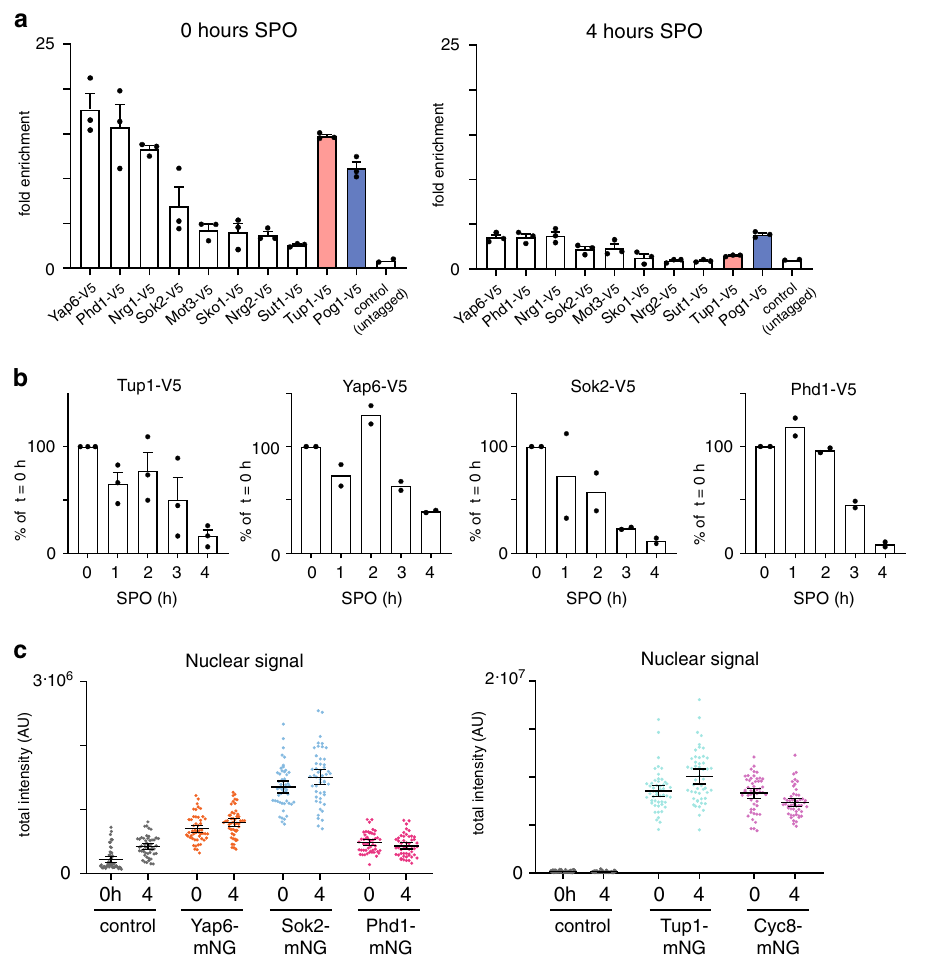
Fig. 6 Tup1 – Cyc8 and TFs dissociate without translocating to the cytoplasm. a Binding of TFs at the IME1 promoter prior to and during entry into meiosis. Diploid cells harbouring V5 tagged TFs ( YAP6- V5, FW3833; PHD1-V5 , FW4466; NRG1-V5 , FW4393; SOK2-V5 , FW5638; MOT3-V5 , FW4383; SKO1-V5 , FW4389; NRG2-V5 , FW4396; SUT1-V5 , FW6974; TUP1-V5 , FW3456; POG1-V5 , FW968) and control cells (untagged, FW1511) were used for the analyses. Samples for ChIP were taken at 0 and 4 h in SPO. Mean and SEM values of n = 3 is displayed, except for control ( n = 2). b Similar as in a , except that multiple time points were taken to analyse the timing of dissociation of Tup1-V5, Yap6-V5, Sok2-V5 and Phd1-V5 from the IME1 promoter. ChIP signals were normalised over HMR , and the 0 h time point was set to 100%. The mean and SEM values of n = 3 (Tup1 – V5), and the mean of n = 2 (Yap6-V5, Sok2-V5 and Phd1-V5) are displayed. c Nuclear signal of Yap6-mNG (FW7473), Sok2-mNG (FW7475), Phd1-mNG (FW7477), Tup1-mNG (FW7644) and Cyc8-mNG (FW7642) prior to (0 h in SPO) and during entry into meiosis (4 h in SPO). Each transcription factor was fused to mNeonGreen (mNG). These cells also expressed mCherry fused to SV40 nuclear localisation signal (NLS) (mCherry-NLS). As a control, the signals of cells harbouring no mNG-tag (FW5199) are displayed. The black bar indicates the mean signal, and each point indicates a single cell measurement ( n = 50 for each sample). The error bars represent the 95% con fi dence